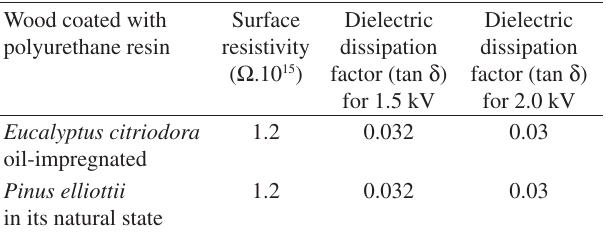
Table 11. Electrical characteristics of wood coated with polyurethane resin. Wood coated with